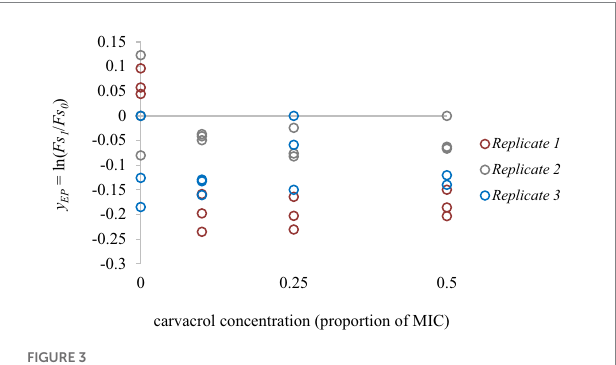
FIGURE 3 The concentration dependent effect of carvacrol on EtBr fluorescent signal intensity. Carvacrol was tested between 0 and 0.5 MIC values (0, 25, 75, and 150 mg/l concentrations). Colors indicate the independent replicates.